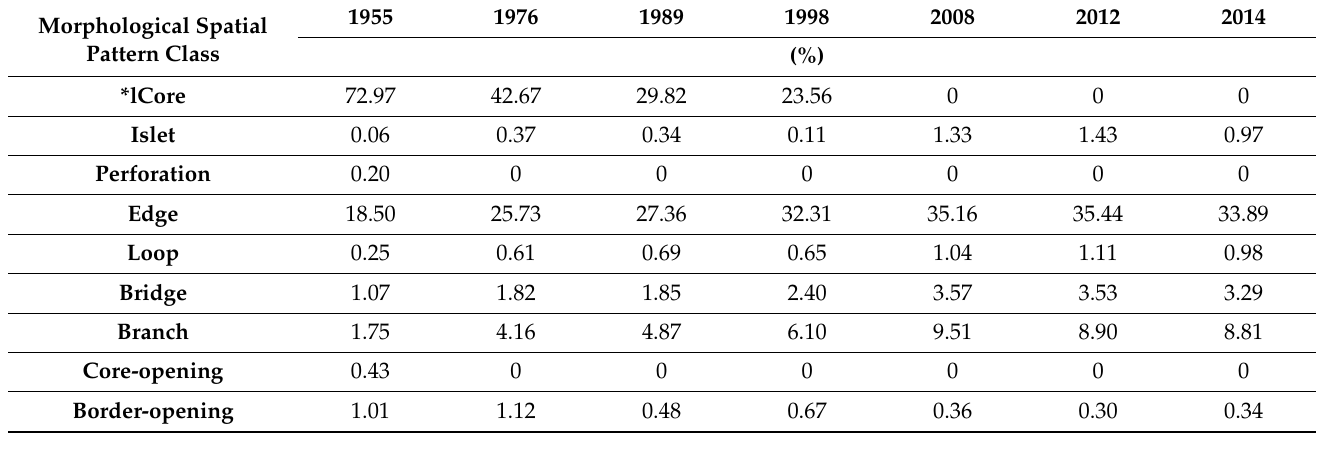
Figure 5. Spatial morphological pattern class composition of the study area for each of the years investigated.